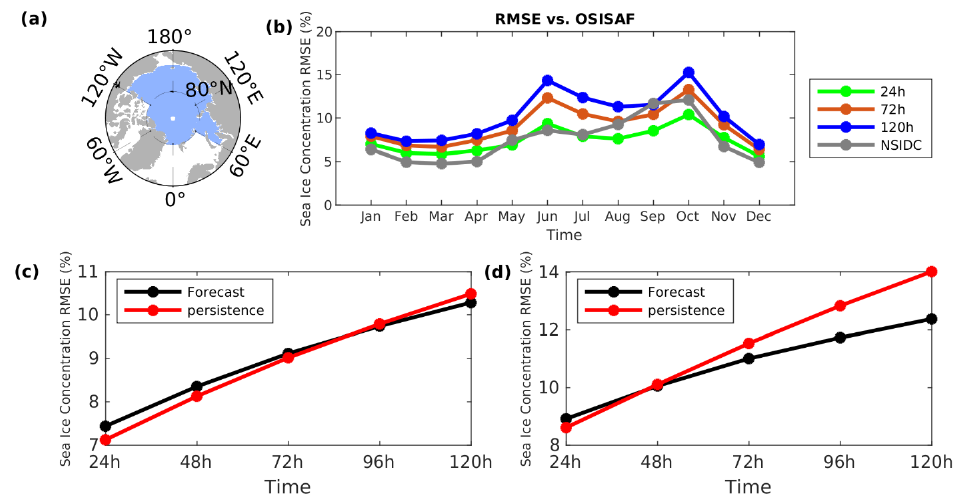
Figure 8. Sea ice concentration RMSE between FIO-COM10 forecast and the OSISAF observation. ( a ) The Arctic domain (blue patched area), averaging region for sea ice concentration RMSE analysis. ( b ) Monthly-mean sea ice concentration RMSE from January to December 2021 over the Arctic domain. ( c ) Annual-mean RMSE of forecast and the corresponding persistence forecast for different lead time in 2021. ( d ) Mean RMSE during 1 August to 30 November 2021 of forecast and the corresponding persistence forecast for different lead time.